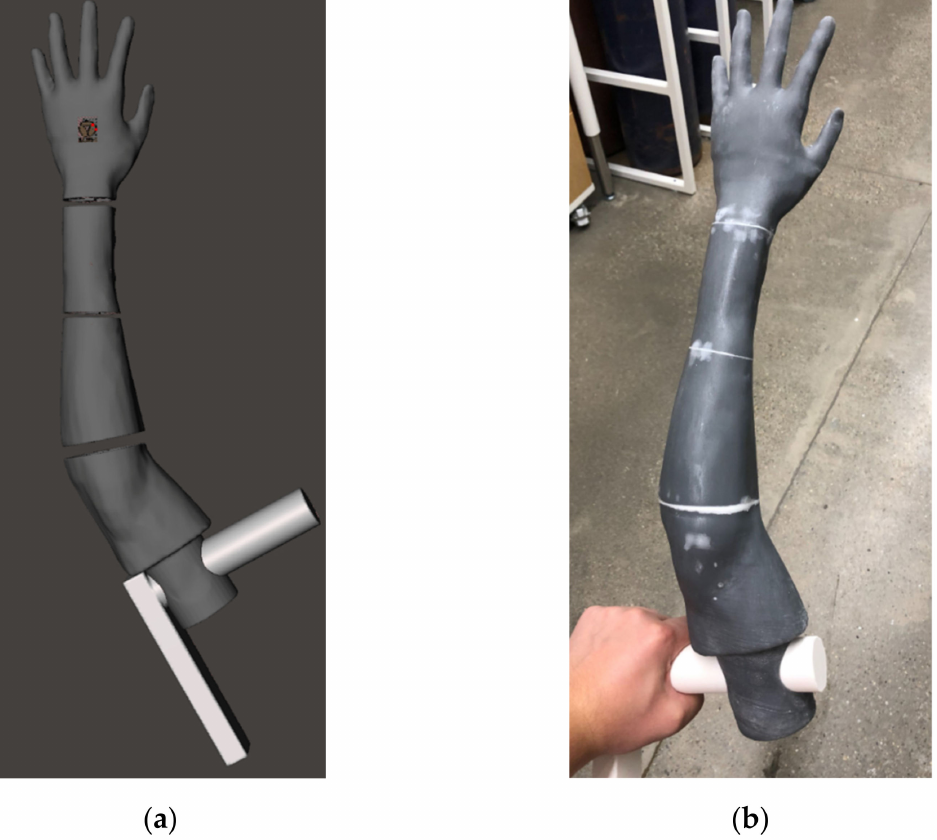
Figure 3. ( a ) Mirrored copy of phantom arm geometry (gray), with grip (white), in Meshmixer. ( b ) Skin covering overmold printed in parts with FormLabs